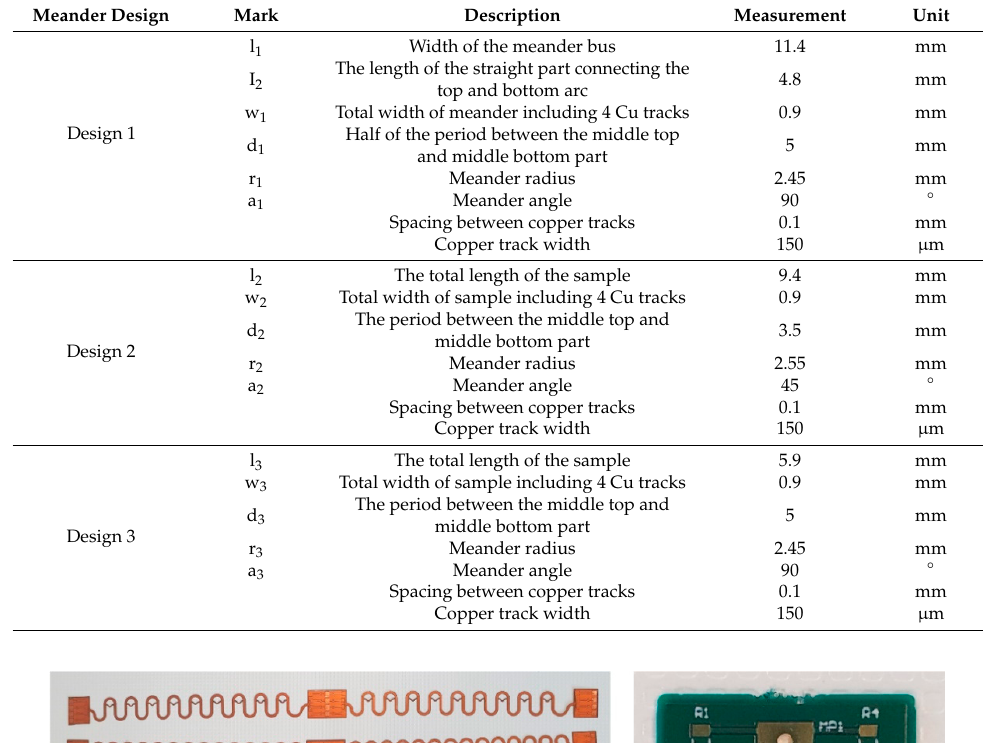
Table 2. Dimensions of meanders.